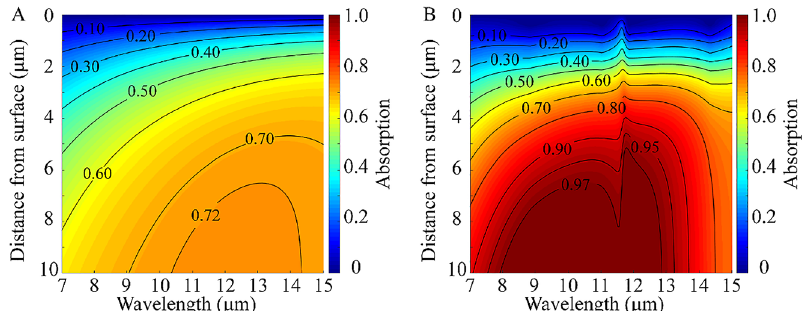
Figure 4: Simulated absorption spectra of (A) planar Si and (B) the broadband absorber for different distances from the